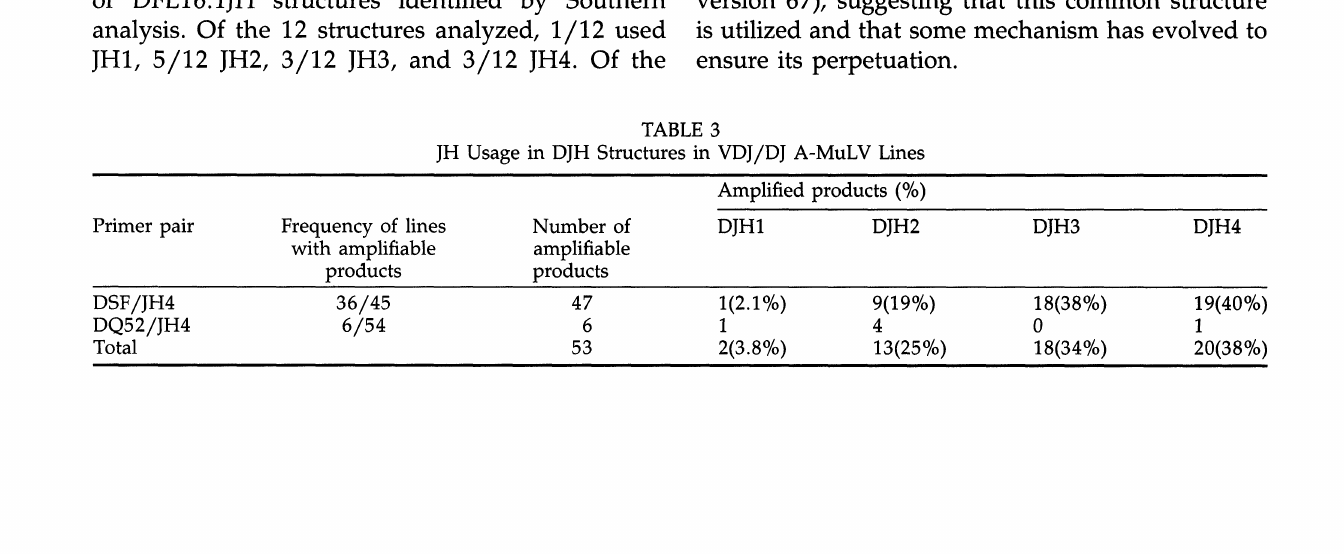
TABLE 3 JH Usage in DJH Structures in VDJ/DJ A-MuLV